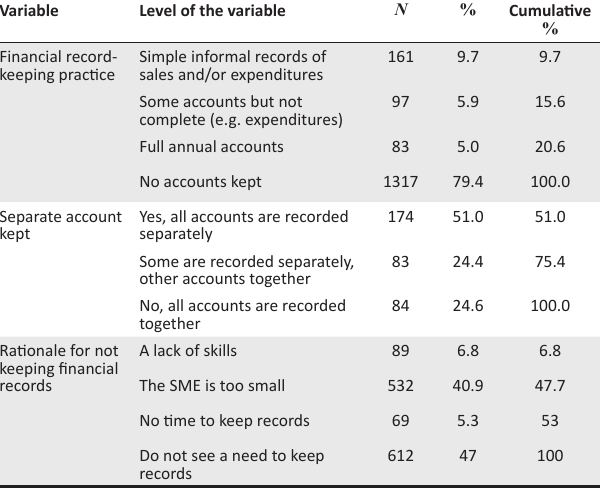
TABLE 2 : Estimates from the logistic regression model relating to financial record-keeping. Variable